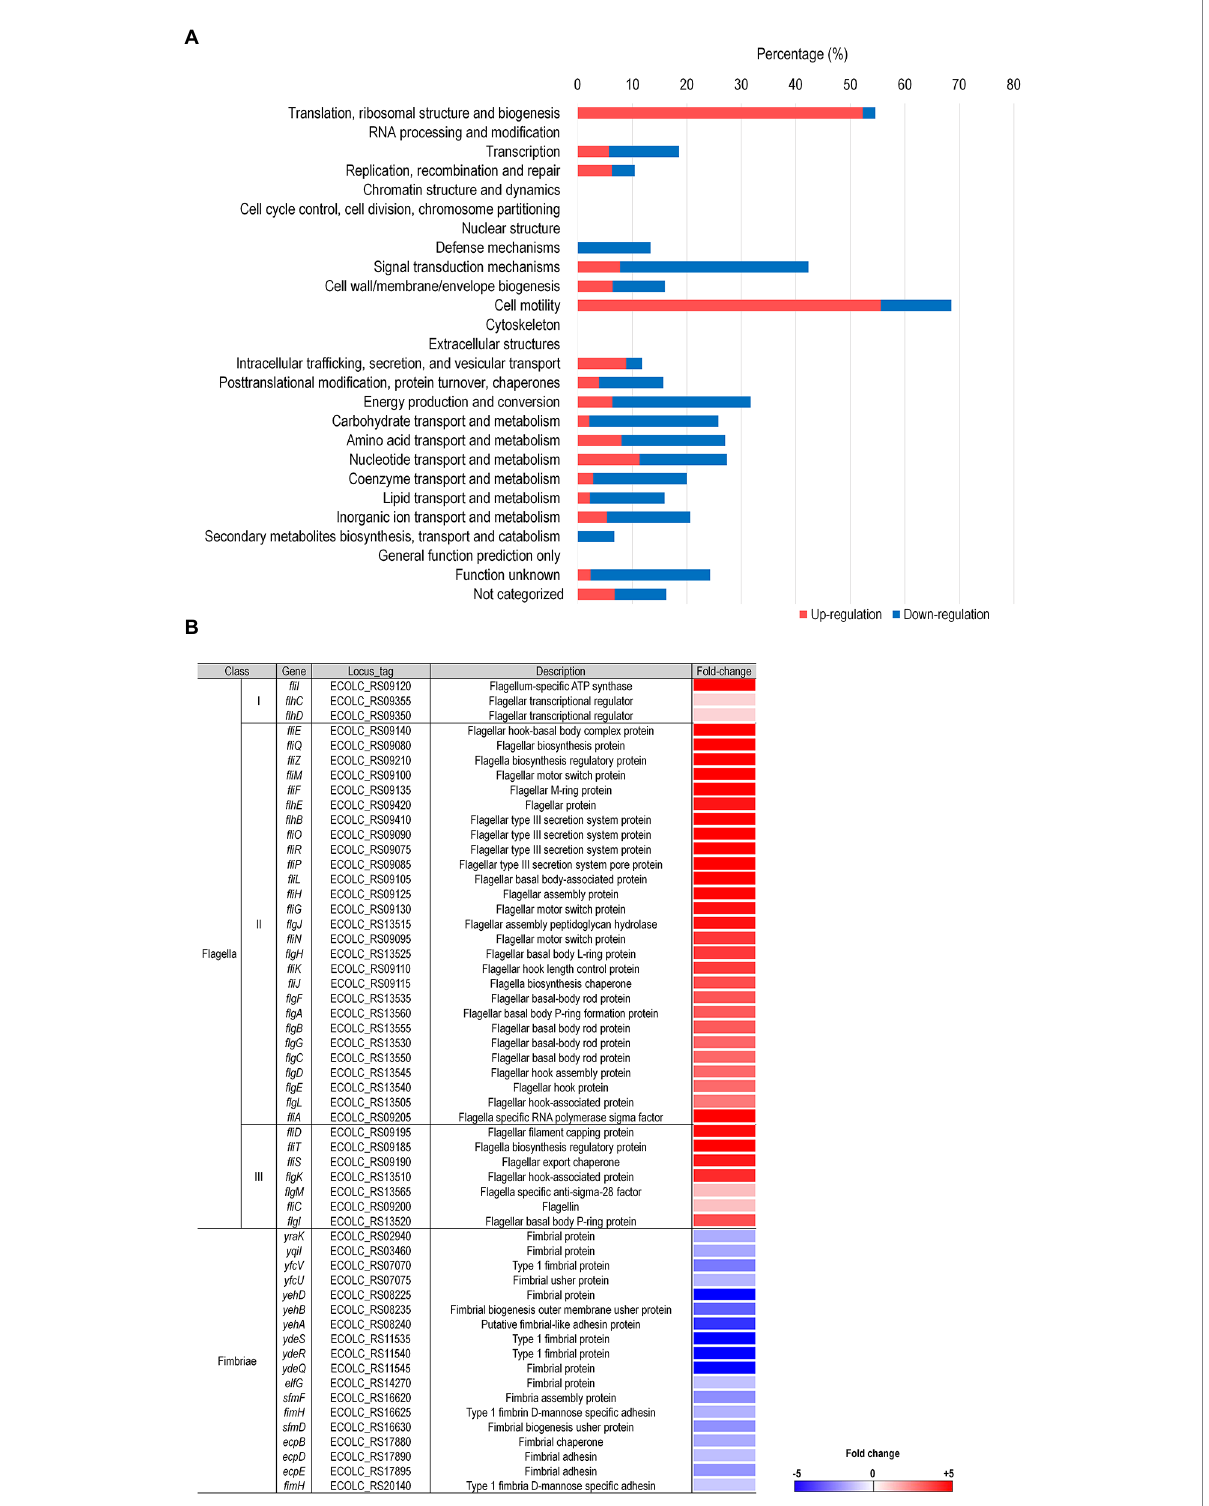
FIGURE 2 Comprehensive transcriptome analysis of E. coli upon treatment with LysPA90. (A) Differentially expressed genes (DEGs) were grouped based on COG analysis. Genes upregulated (red bars) or downregulated (blue bars) more than six-fold were functionally grouped. The number of DEGs found in each category was divided by the total number of genes in the same category and is shown as a percentile. (B) Genes associated with flagella and fimbriae were sorted from the RNA-Seq data and the expression ratio (LysPA90/non-treated) is displayed in a colorimetric gradient: downregulation in blue and upregulation in